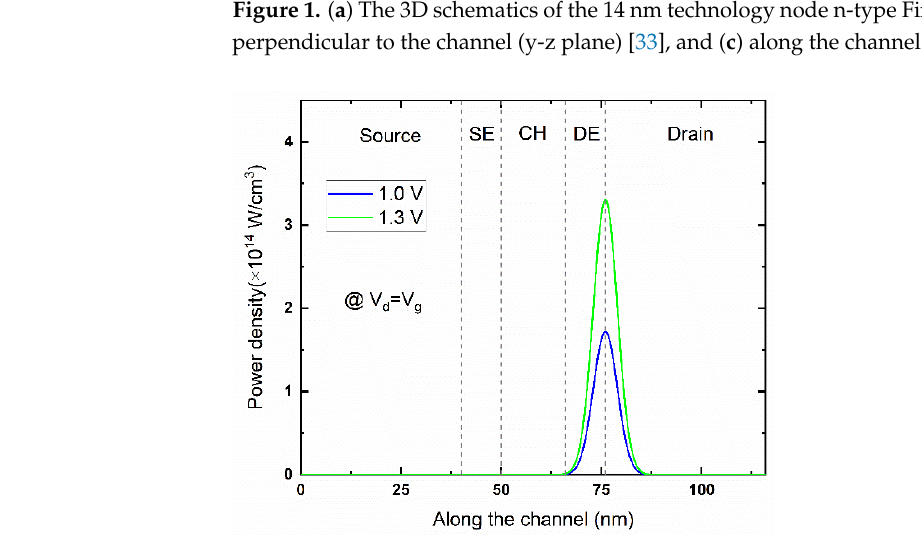
Figure 2. Gaussian distribution is applied to model the heat generation rate along the channel for FinFET